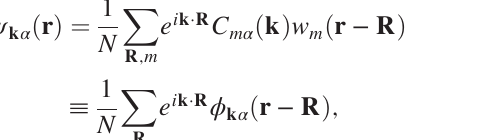
FIG. 1. Experimental setup and measurement protocol. (a) Ex- perimental scheme of polarization-modulated, angle-resolved photoemission spectroscopy. A polarization-axis-tunable, lin- early polarized, femtosecond XUV pulse (21.7 eV) is focused onto a bulk 2 H-WSe 2 crystal at an angle of incidence of 65° with respect to the surface normal, ejecting photoelectrons that are detected by a time-of-flight momentum microscope, allowing us to measure the energy- and momentum-resolved photoemis- sion intensity as a function of the polarization axis angle θ - I ð E; k ; k ; θ Þ . (b) Sketch of the first Brillouin zone of x y 2 H-WSe — band 2 . (c) Example of three-dimensional raw data ; k structure mapping [ I ð E; k ] using p -polarized XUV radiation, x y Þ an associated cut through high-symmetry directions (K 0 - Γ -K and − 0 . 25 eV). M 0 - Γ -M), anda constantenergycontour ( E − E VBM ¼ (d) Two-dimensional cut through the 4D ARPES intensity I ð E; k ; k ; θ Þ : at different polarization-axis angles ( θ ), at x y − 0 . 25 eV, and for given K and K ’ E − E VBM ¼